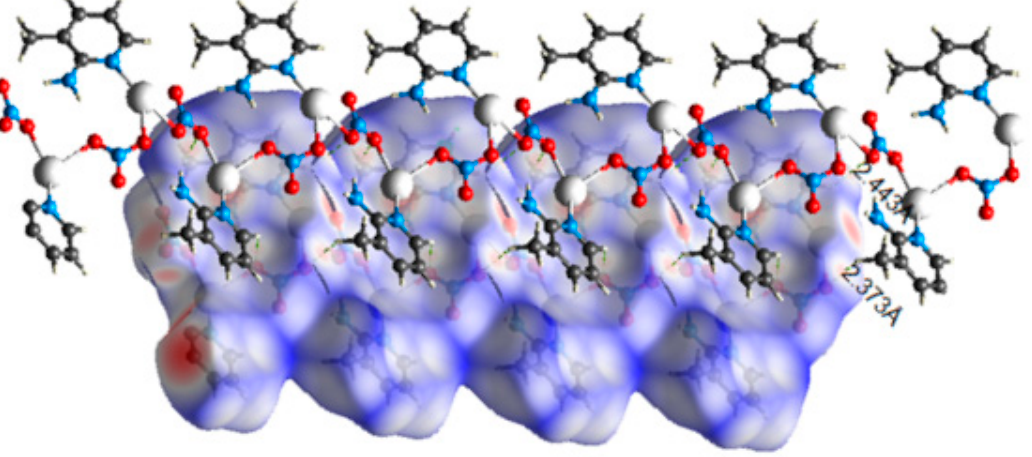
Figure 6. View of the three-dimensional Hirshfeld surface of 4 , plotted over d norm in the range of − 1.1545 to 1.4419.